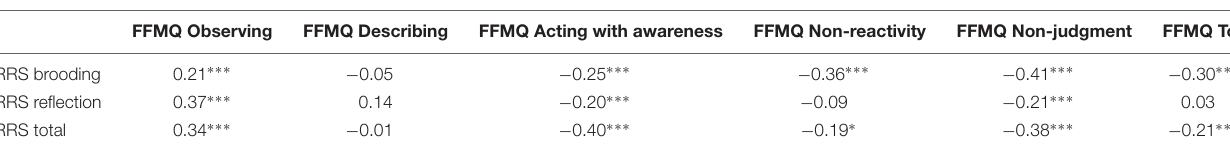
TABLE 2 | Relationship between mindfulness and rumination. FFMQ Observing FFMQ Describing FFMQ Acting with awareness FFMQ Non-reactivity